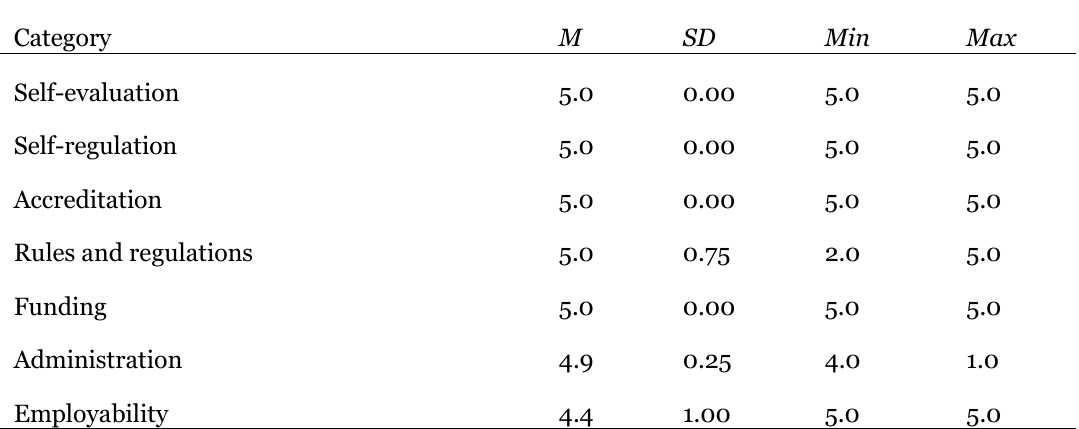
Management Dimension’s